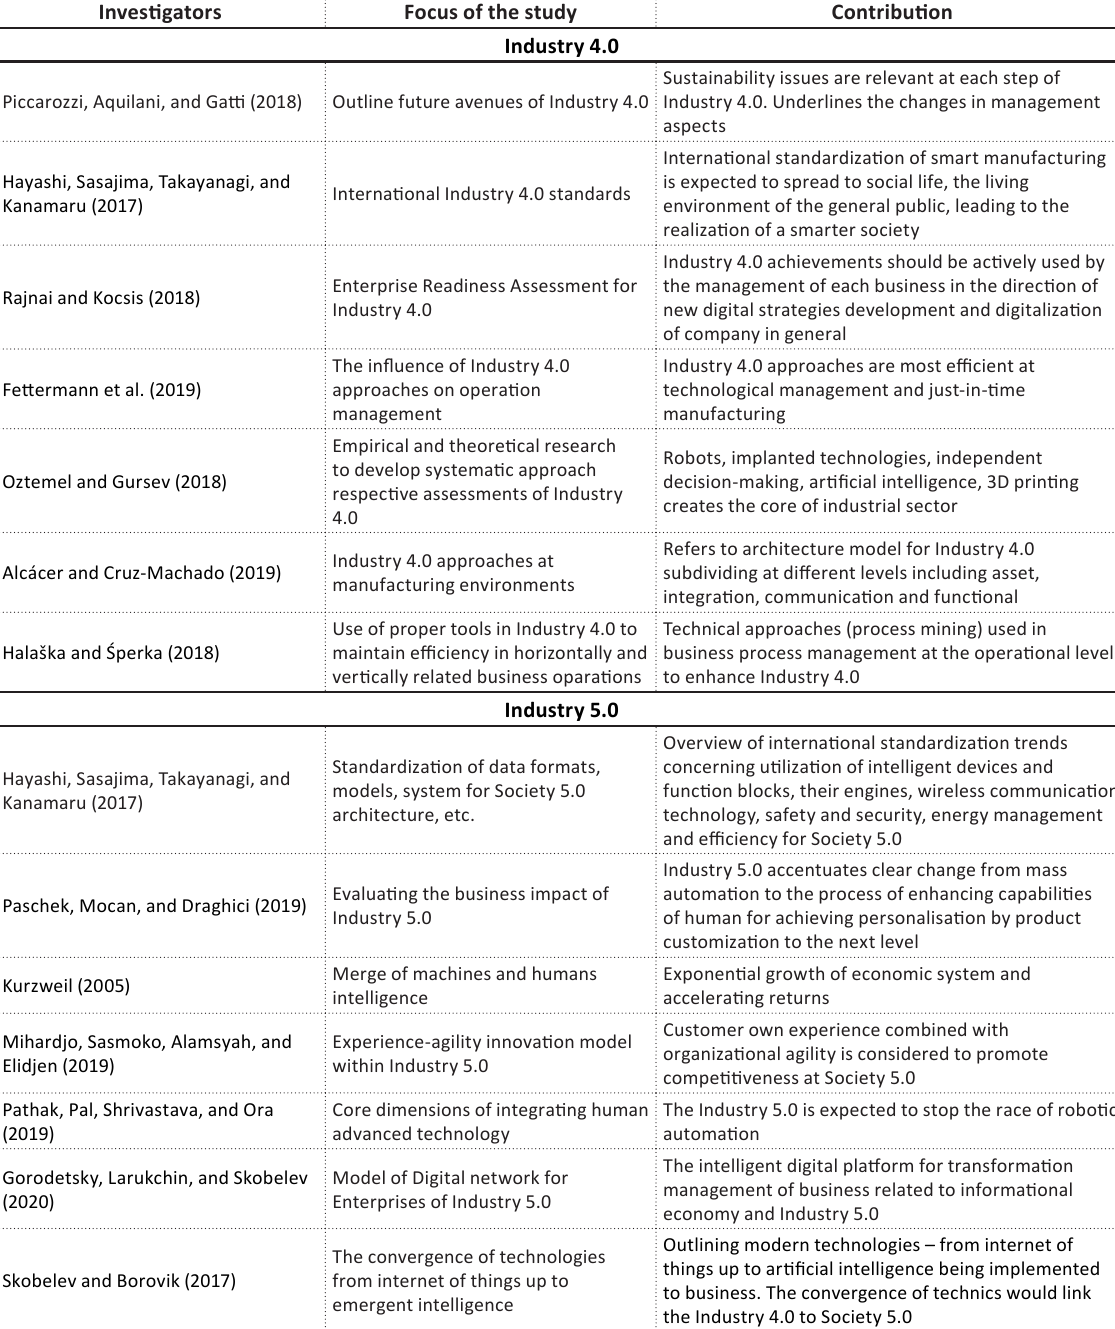
Table 1. The economic systems transformations under the influence of industrial revolutions